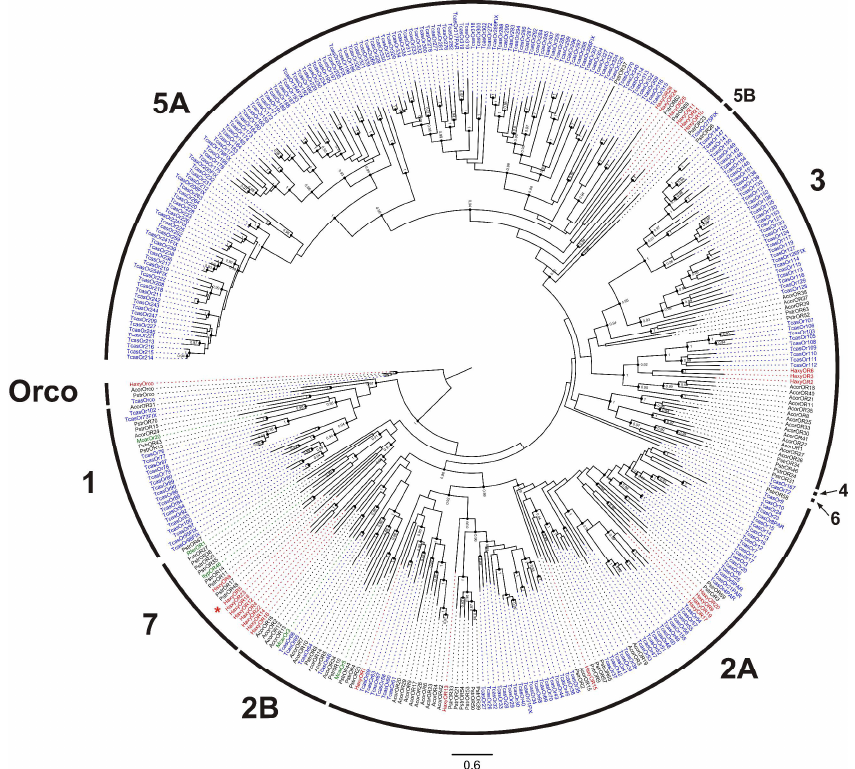
Figure 1. Phylogenetic tree of odorant receptors (ORs). Red: Harmonia axyridis (Haxy); blue: Tribolium castaneum (Tcas); black: Anomala corpulenta (Acor) and Phyllotreta striolata (Pstr); green: Functionally characterized ORs of Megacyllene caryae (Mcar), Ips typographus (Ityp), and Rhyncophorus ferrugineus (Rfer). External numbers represent known groups of ORs. Numbers and symbols at nodes represent support values higher than 0.9, where 1 represents maximal support. Asterisk represents the OR with a male-biased expression.